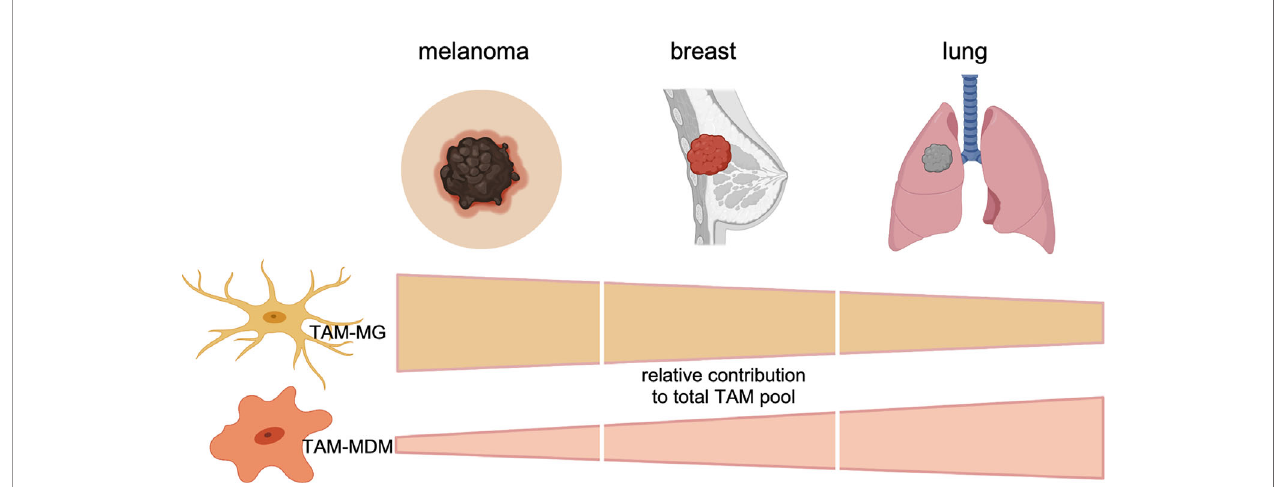
FIGURE 2 | Relative contribution of each TAM subpopulation to the total TAM pool in BrMs derived from melanoma, breast cancer, or lung cancer. Data represent cumulative, relative data derived from preclinical (mouse models) and clinical (human) fi